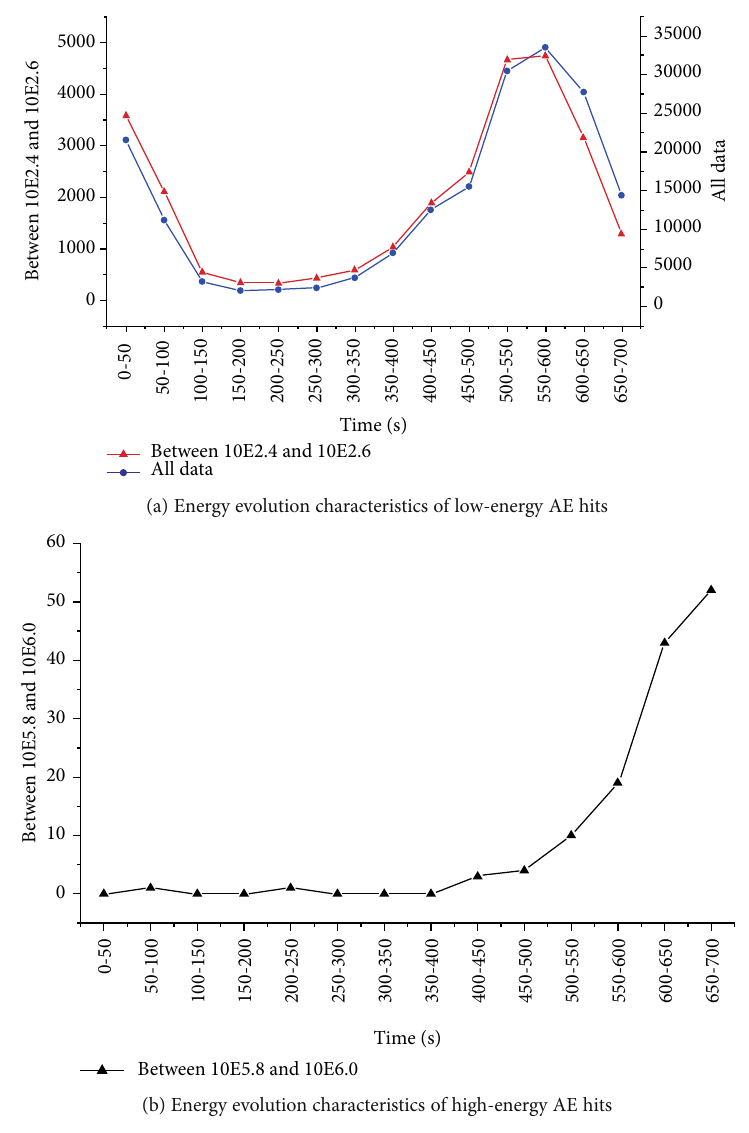
Figure 10: Energy evolution characteristics of low-energy and high-energy AE hits.